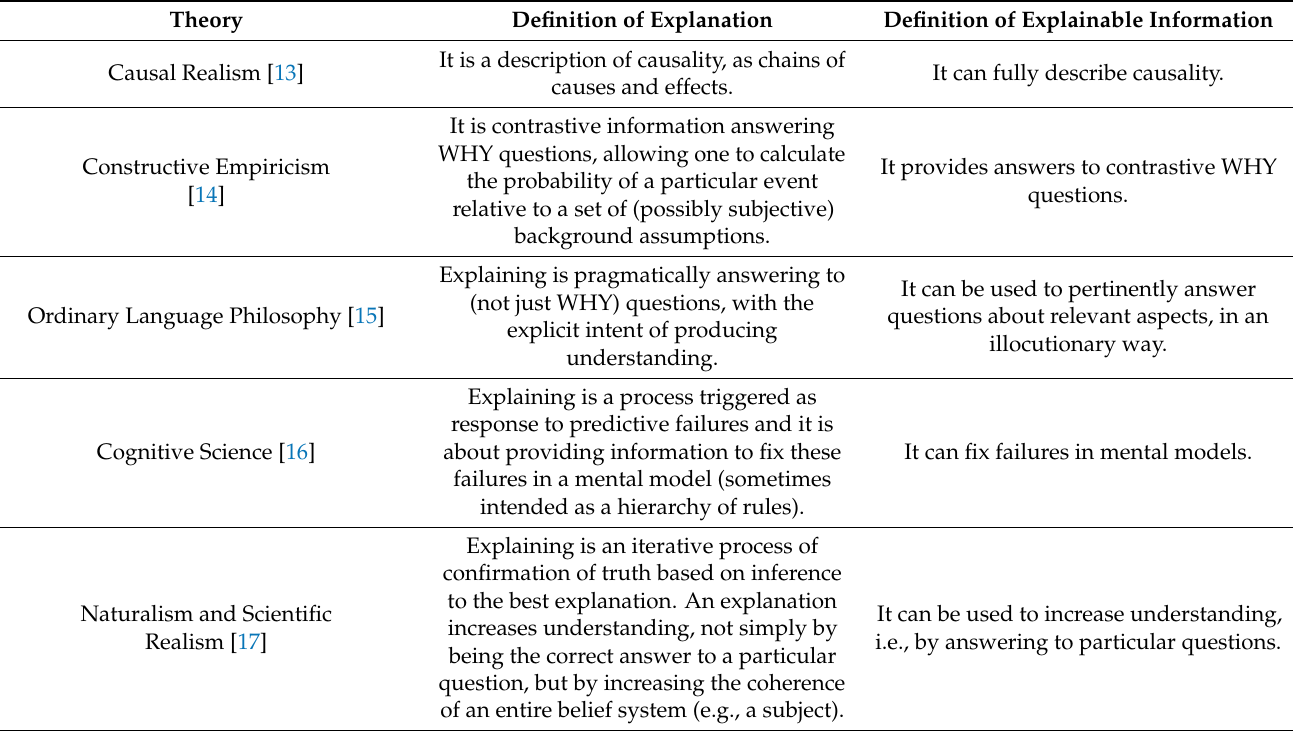
Table 1. In this table we summarise the definitions of explanation and explainable information for each one of the identified theories of